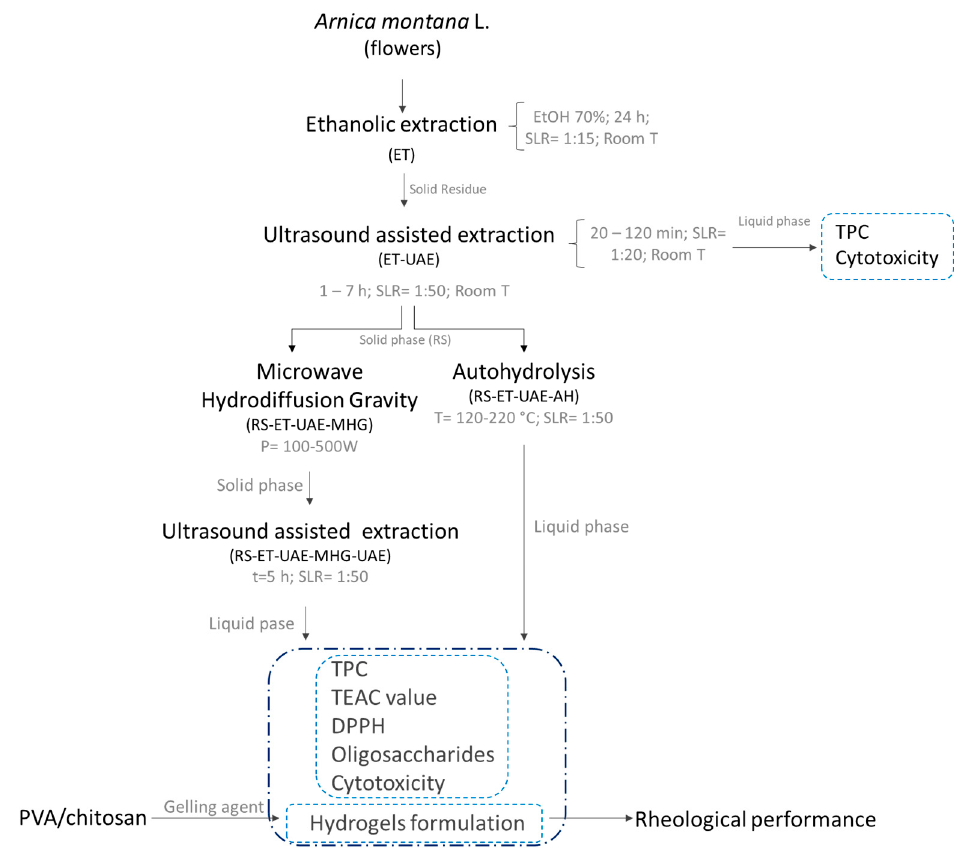
Figure 1. Diagram of the extraction process carried out to produce extracts from flowers of Arnica montana L. TPC, total phenolic compounds; PR, means reducing power; DPPH, free radical scav- enging activity of the extract on 1,1-diphenyl-2-picryl-hydrazyl; TEAC value, Trolox equivalent antioxidant capacity.